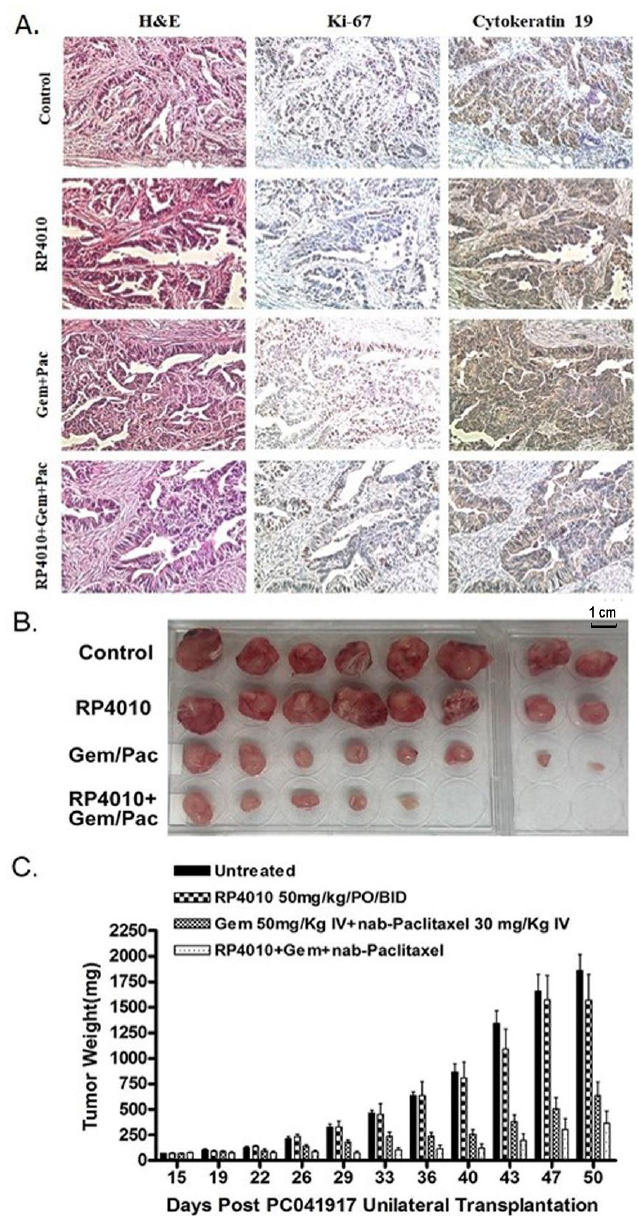
Figure 6. RP4010 potentiated the anti-cancer activity of gemcitabine/nab-paclitaxel in patient-derived xenograft (PDx). ( A ) H&E and immunostaining of tissue sections of the PDx tumors harvested from mice who received different treatments as well as from untreated controls. Images were taken at 200× magnification. ( B and C ) The mice with PDx were treated with either RP4010 or gemcitabine/nab-paclitaxel, or a combination of RP4010 with gemcitabine/nab-paclitaxel, and the effect of these treatments on tumor size and weight was assessed up to 50 days post-transplantation of PDx. Treatment started at 15 days post-transplantation when the tumors were palpable. All the tumors were collected 50 days post-transplantation at the culmination of the experiment.